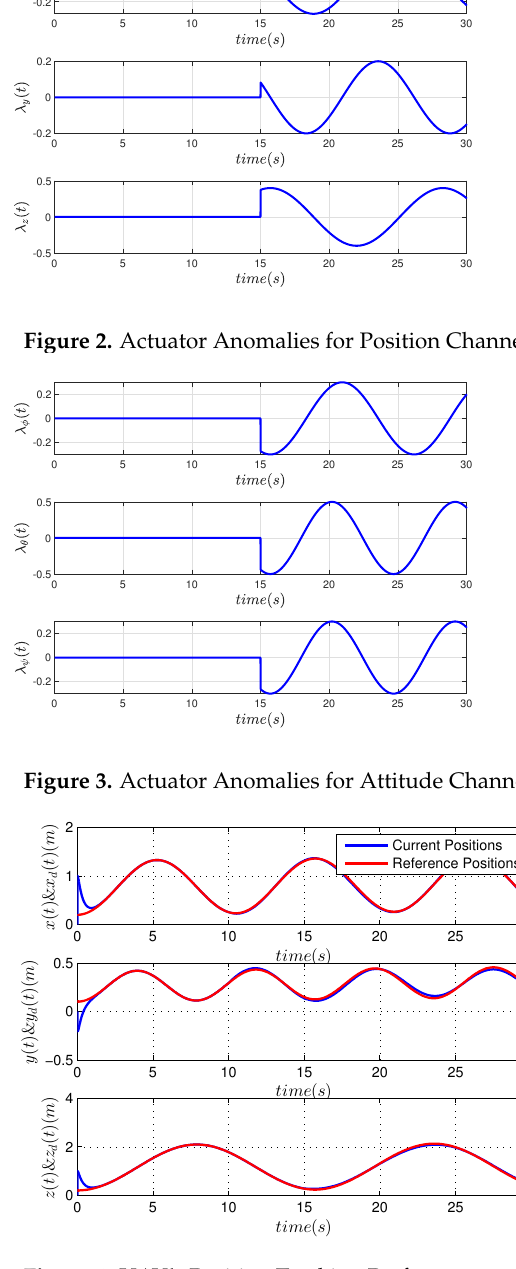
Figure 4. UAV’s Position Tracking